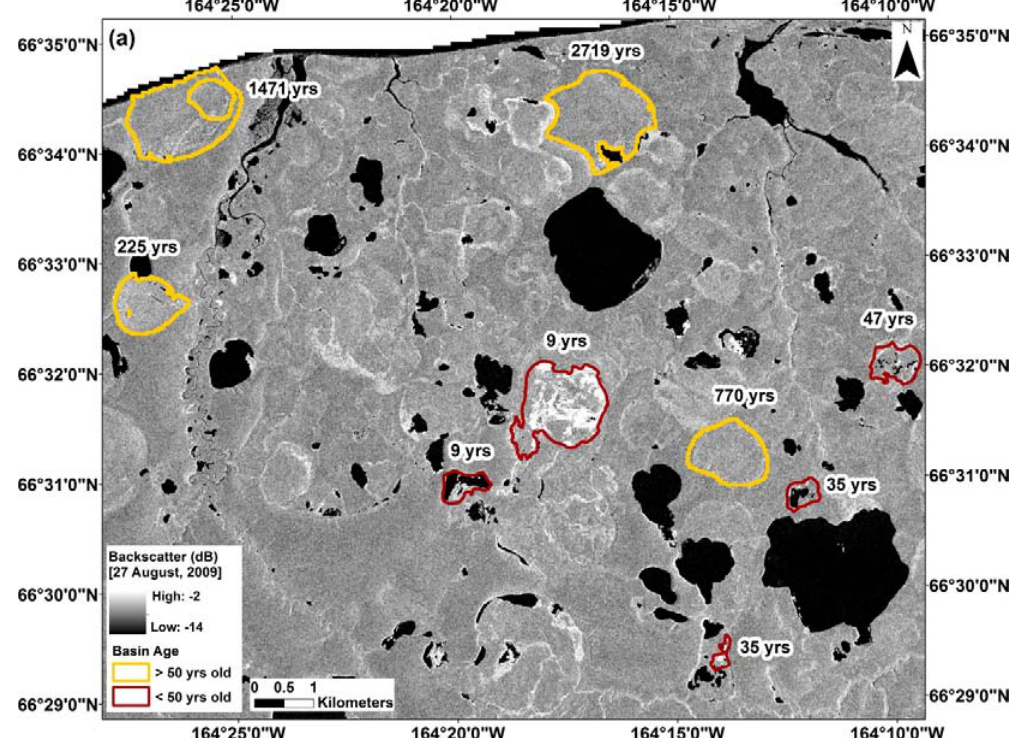
Figure 5. Backscatter and NDVI properties of DTLBs at various stages in a subset of the study area on the northern Seward Peninsula as observed in: ( a ) TerraSAR-X image (3 m spatial resolution) on 27 August 2009; and ( b ) Landsat-5 TM based NDVI (30 m spatial resolution) on 13 July